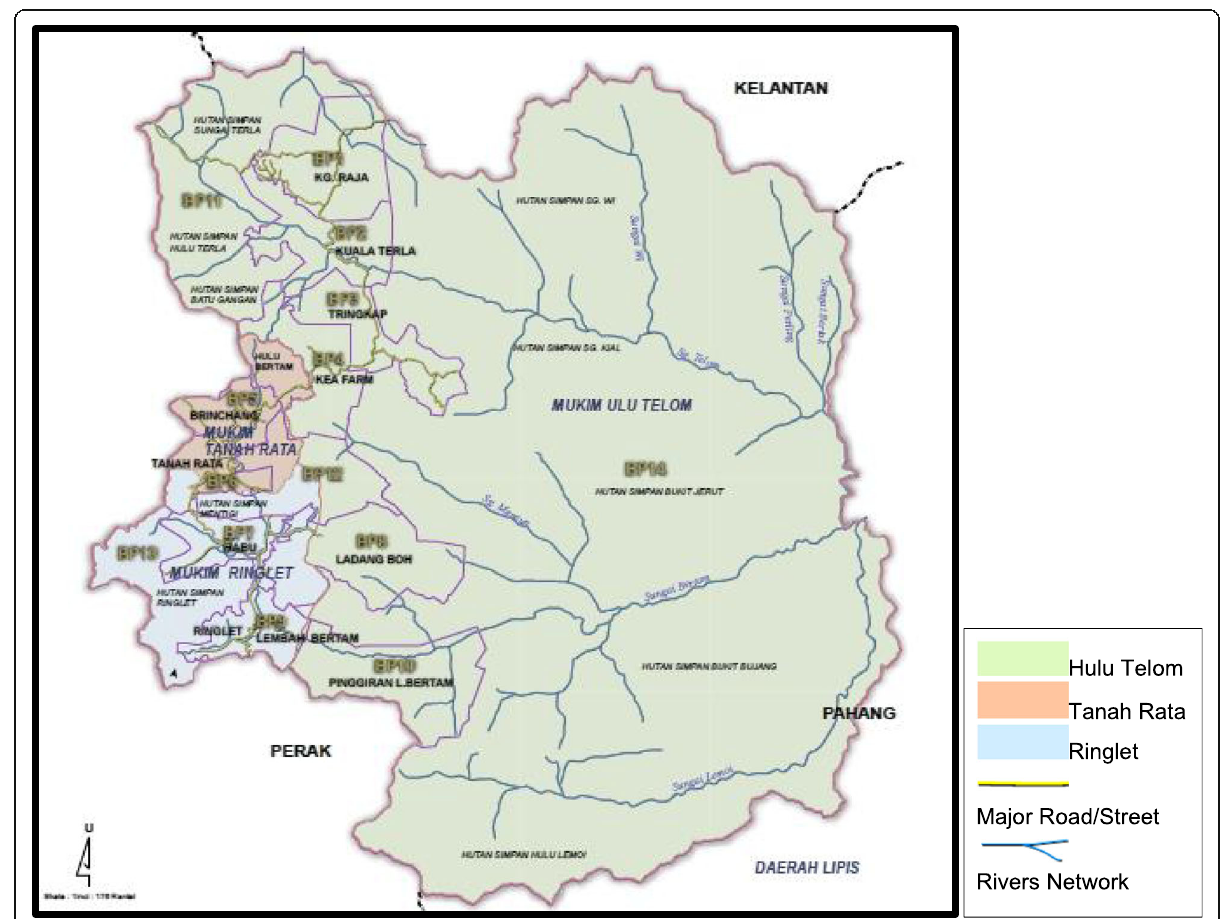
Fig. 2 Map of Cameron Highlands with three major sub-districts: Hulu Telom, Tanah Rata and Ringlet. The map also visualizes the rivers channel networks within the highlands area (RTD